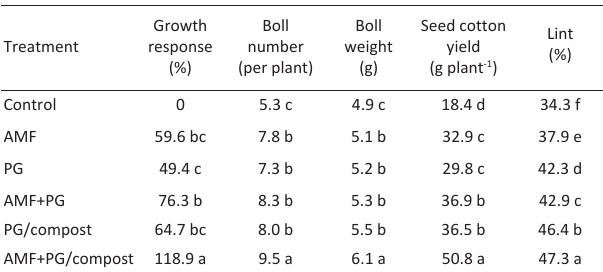
Table 2 - Growth response and some yield components of cot- ton plants grown with different treatments of arbuscu- lar mycorrhizal fungi (AMF) and added phosphogyp- sum (PG) Growth Treatment response